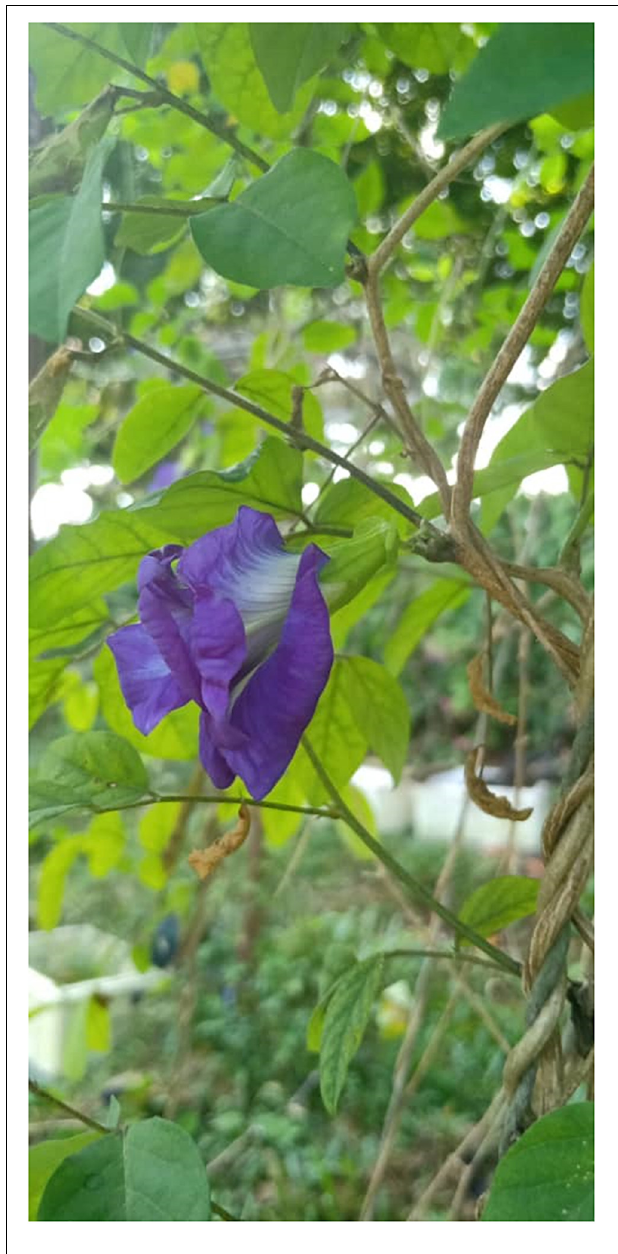
FIGURE 1 | Blue pea flower ( Clitoria ternatea